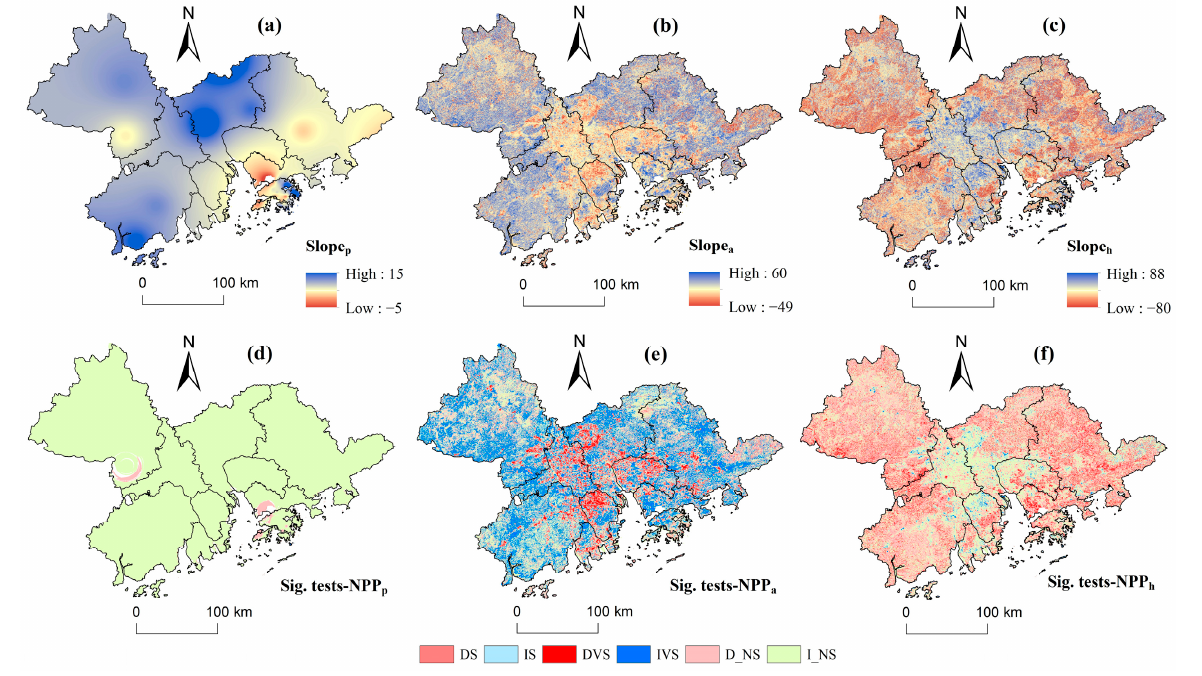
Figure 5. Trends in annual ( a ) NPP p , ( b ) NPP a , and ( c ) NPP h from 2000 to 2020, and slope significance tests for ( d ) NPP p , ( e ) NPP a , and ( f ) NPP h in the study area. DS, decreased significantly (0.01< p ≤ 0.05); IS, increased significantly (0.01 < p ≤ 0.05); DVS, decreased very significantly ( p ≤ 0.01); IVS, increased very significantly ( p ≤ 0.01); D_NS, decreased or non-significantly ( p > 0.05); I_NS, increased non-significantly ( p > 0.05).